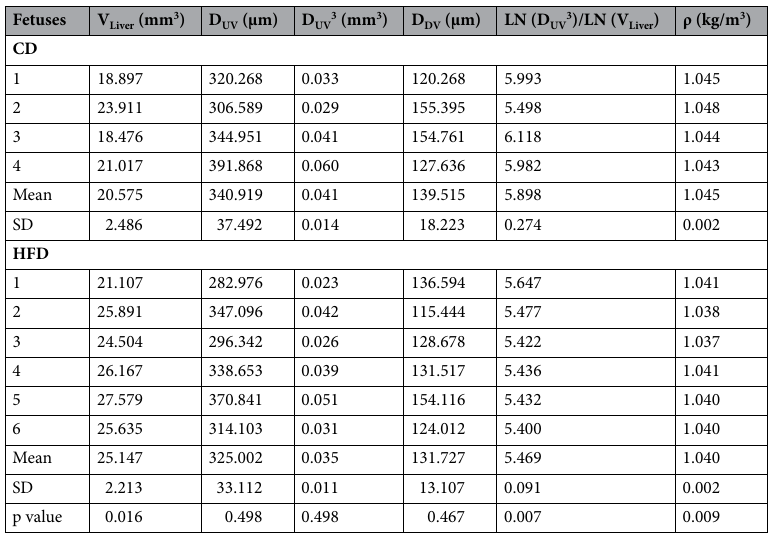
Table 2. Liver volume, diameter of umbilical vein, diameter of ductus venosus and hepatic density in mouse fetuses measured by synchrotron radiation-based phase-contrast computed tomography at SPring-8. V Liver liver volume, D UV diameter of umbilical vein, D DV diameter of ductus venous, ρ hepatic tissue